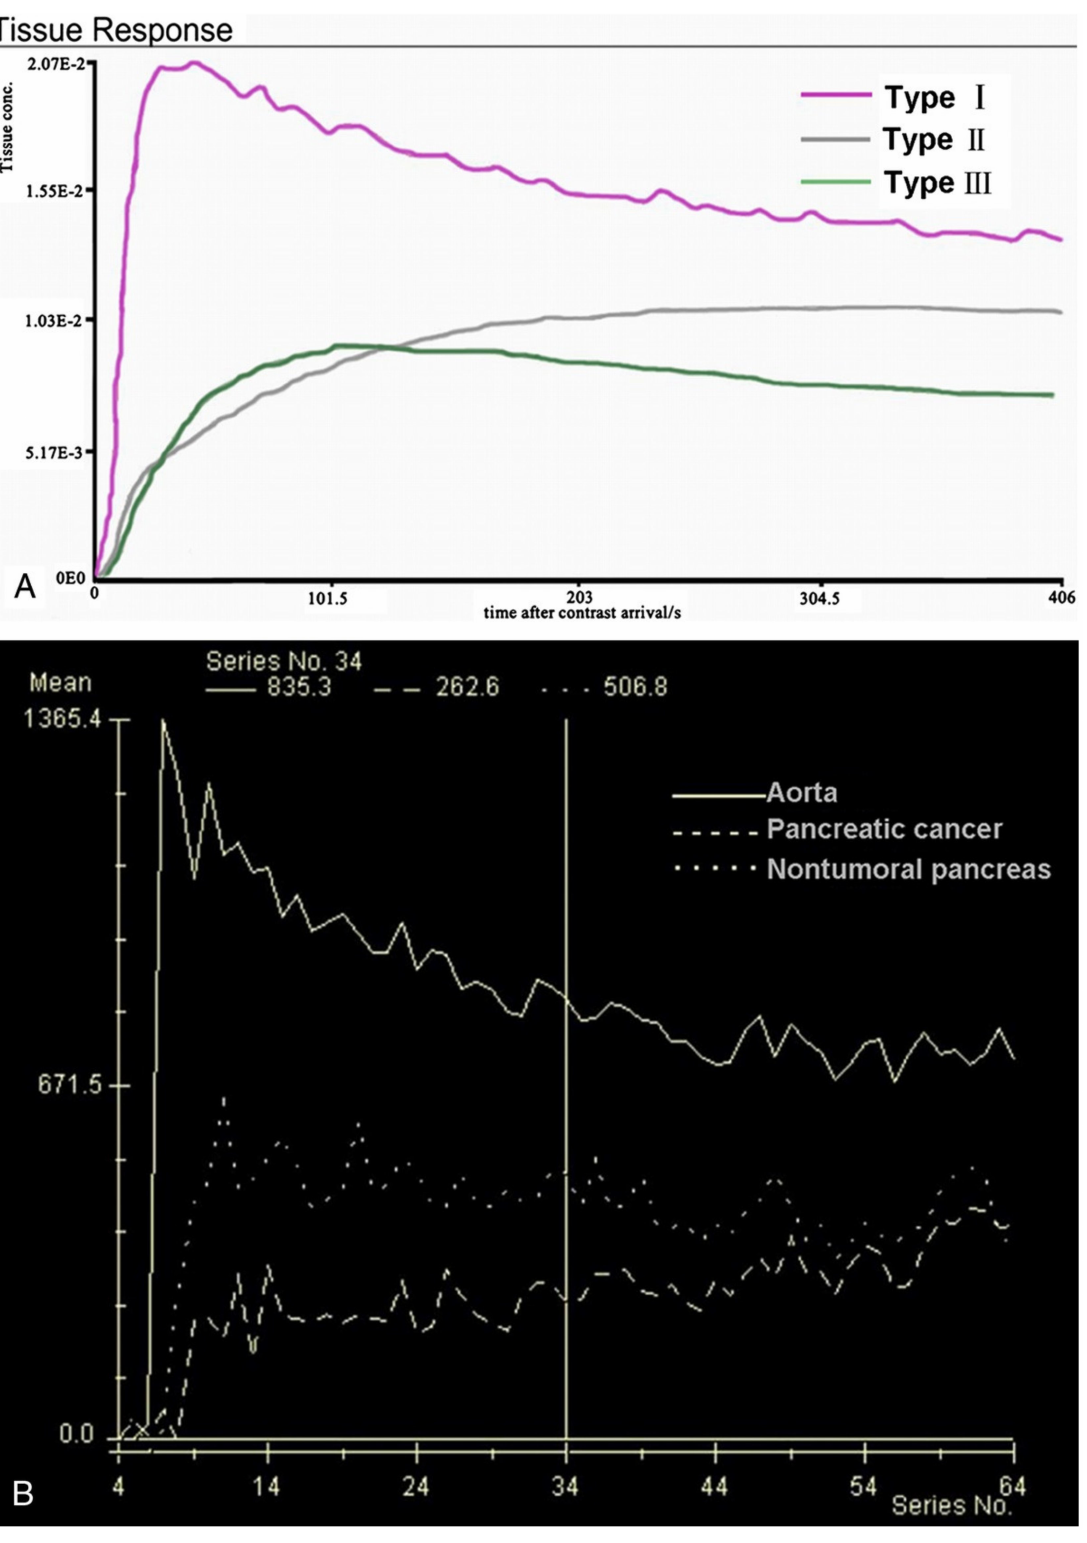
Figure 1. ( A ) SI-T curves of all nontumoral pancreatic tissue showed type I pattern enhancement. Pancreatic tumors showed type II or type III pattern enhancement; ( B ) Curve graph shows that pancreatic tumor enhances lesser than surrounding nontumoral pancreatic tissue. Time–signal– intensity curves selected for further data evaluation: type I, characterized by quick enhancement and quick washout; type II, with slow enhancement, which is followed by slow constant enhancement; type III, slow enhancement followed by slow washout